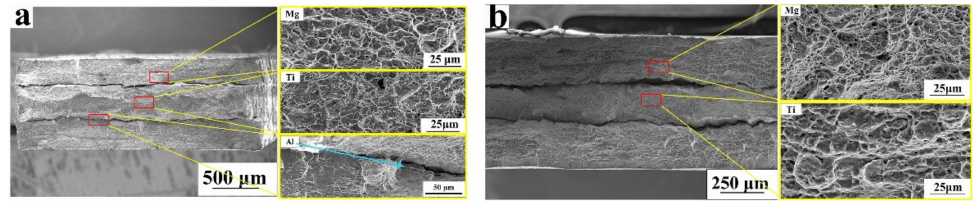
Figure 8. Fracture morphology of the rolled Mg-(Al-)Ti sheets after heat treatment: ( a ) Mg-Al-Ti sheet; ( b ) Mg-Ti sheet, the red boxes were the related Mg, Ti and Al